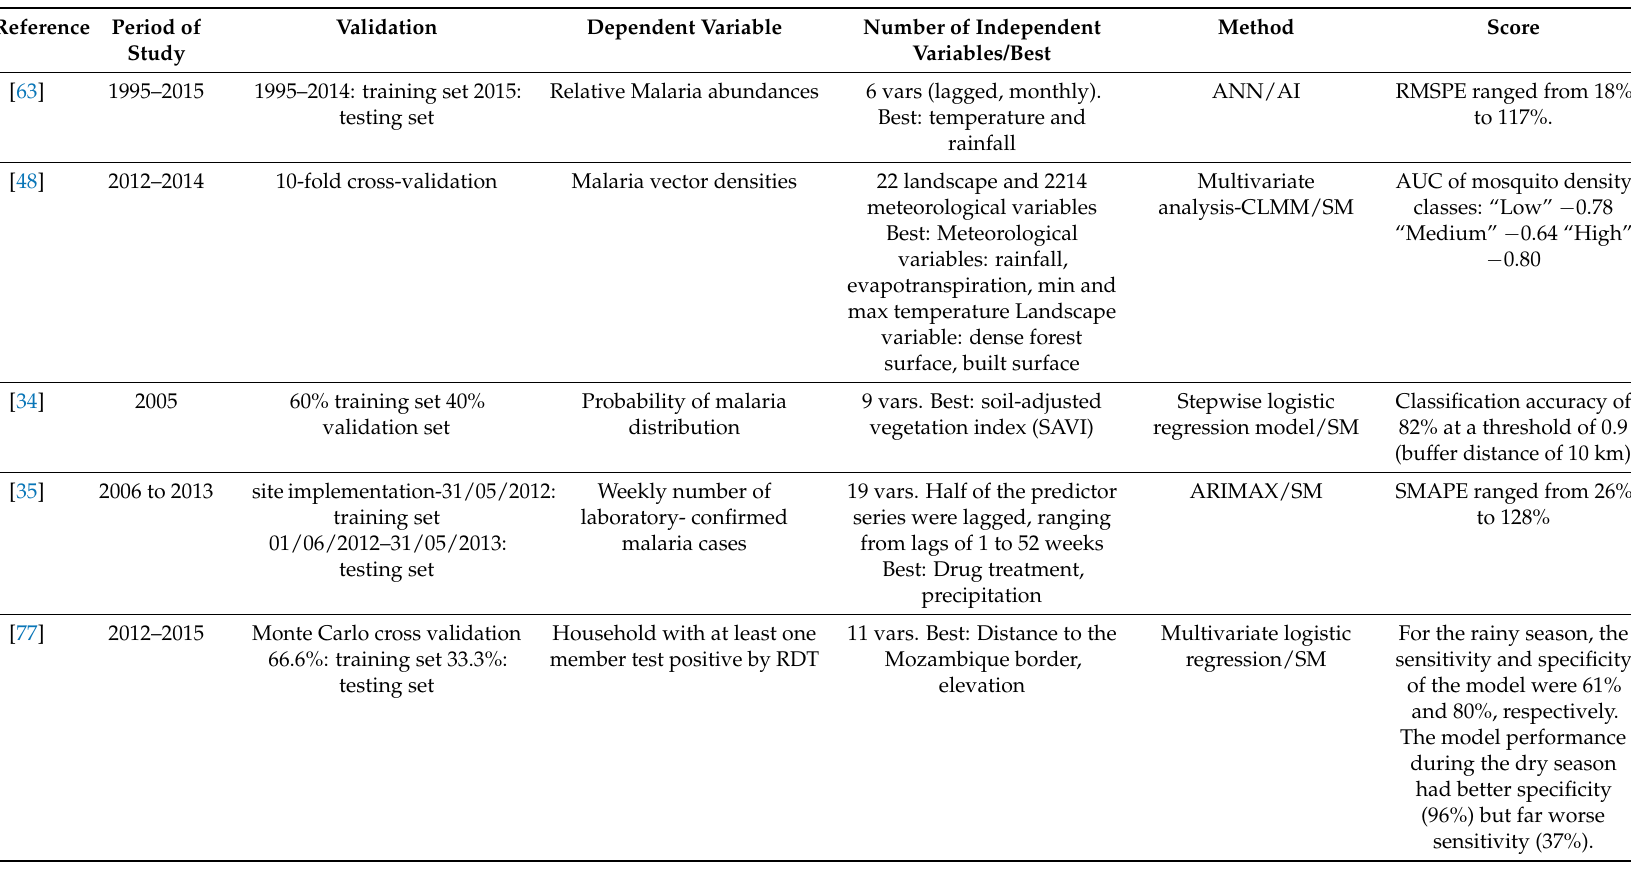
Table A1. Summary table of malaria predictive studies included in review AI: Artificial Intelligence, SM: Statistical